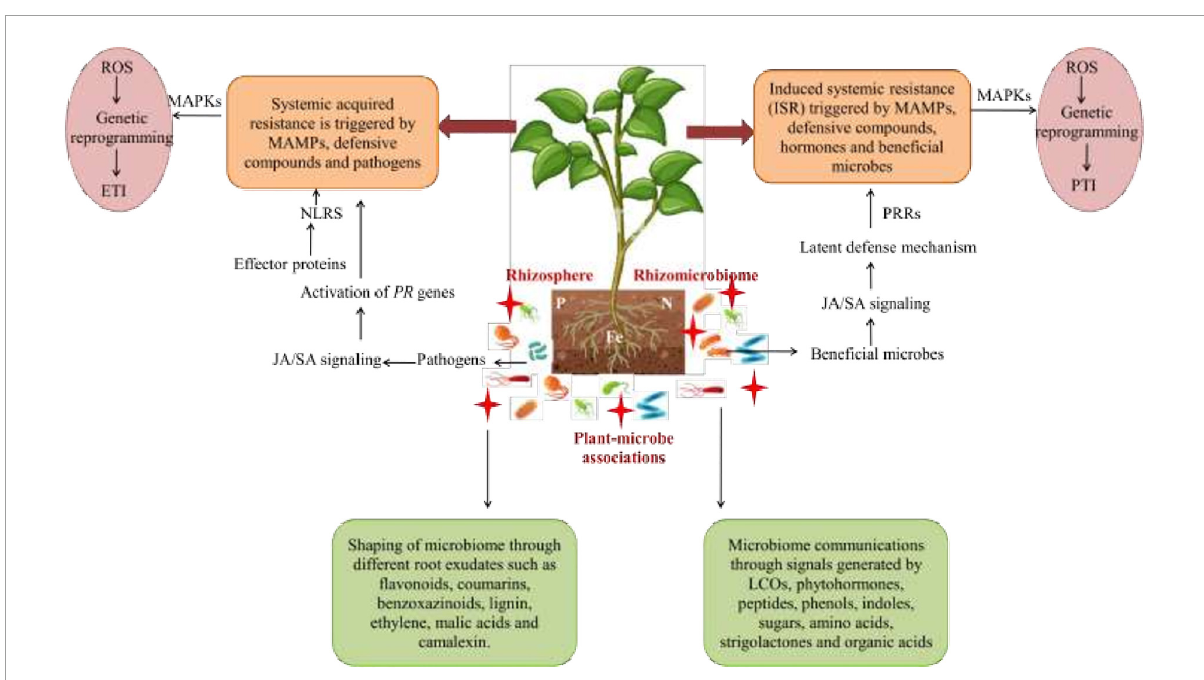
FIGURE6 Microbe-mediated signaling mechanisms comprising of systemic acquired resistance (SAR) and induced systemic resistance (ISR) co-linked with plant defense system with the aid of signaling molecules. Beneficial microbes activate ISR that further activates ET, the SA/JA signaling pathway where pathogens stimulate SA levels and trigger SAR. The signaling cascade for immunity against stressors also activates the downstream signaling cascade by which effector proteins are detected by NLRs in order to activate MAPKs that generate ROS through genetic reprogramming for further activation of ETI. Moreover, plants also trigger defense processes to counteract stresses by MAMPs with the aid of PRR receptors in order to activate MAPKs for ROS generation by genetic reprogramming for further activation of PTI. SA, salicylic acid; JA, jasmonic acid; ET, ethylene; PR, pathogenesis; MAMPs, microbe-assisted molecular patterns; NLRs, nucleotide-binding leucine-enriched repeat receptors; MAPKs, mitogen-activated protein kinases; ROS, reactive oxygen species; PRR, pattern-recognition receptors; ETI, effector-triggered immunity; PTI, pattern-triggered